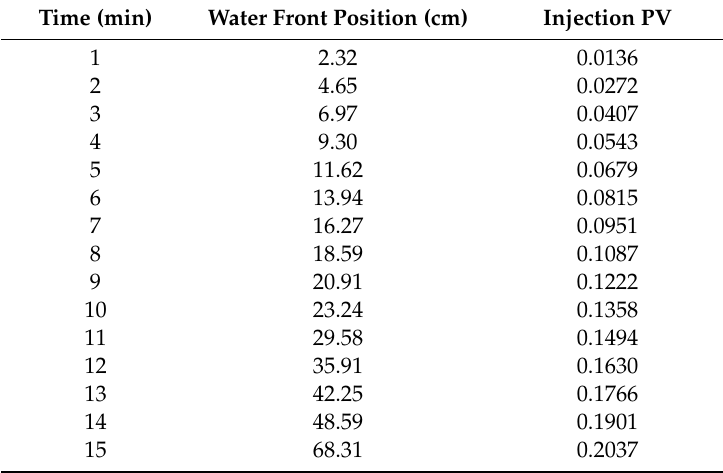
Figure 10. Residual oil distribution of waterflooding when injecting 0.101 PV (left, water breakthrough) and 0.84 PV (right) of water.